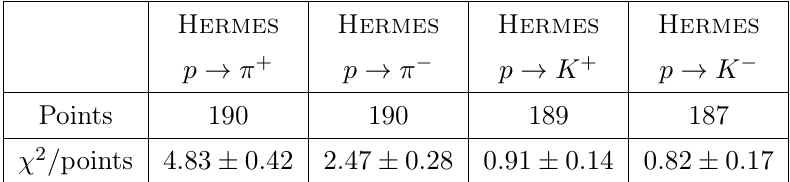
Table 6 . Number of points analyzed and (cid:31) 2 values for SIDIS off a proton target. Hermes Hermes Hermes Hermes Compass Compass